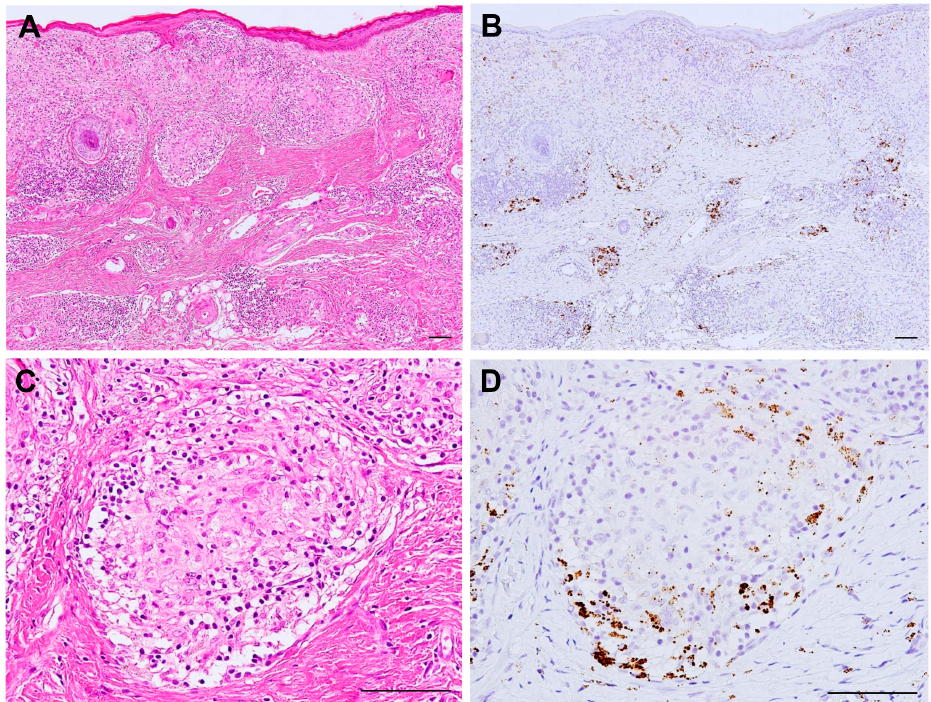
Figure 4. Active P. acnes infection in granulomatous inflammation of cutaneous sarcoidosis. Hematoxylin–eosin stain and immunohistochemistry with P. acnes -specific PAB antibody are shown pairwise. Many granulomas are found in the dermis with prominent lymphocytic infiltration ( A ). Many PAB-reactive P. acnes (in brown color) are found corresponding to the areas of granulomatous inflammation ( B ). In a non-caseating epithelioid cell granuloma ( C ), P. acnes is abundant in the peripheral area with more lymphocytic infiltration ( D ). All photos are original. Scale bar: 100 μ m.